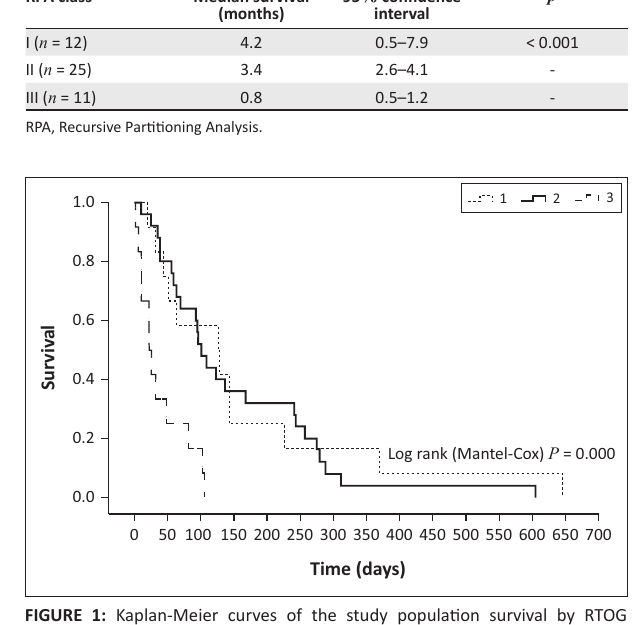
TABLE 3: Details of study cohort by Recursive Partitioning Analysis class. RPA n Age Mean ± s.d. (years)